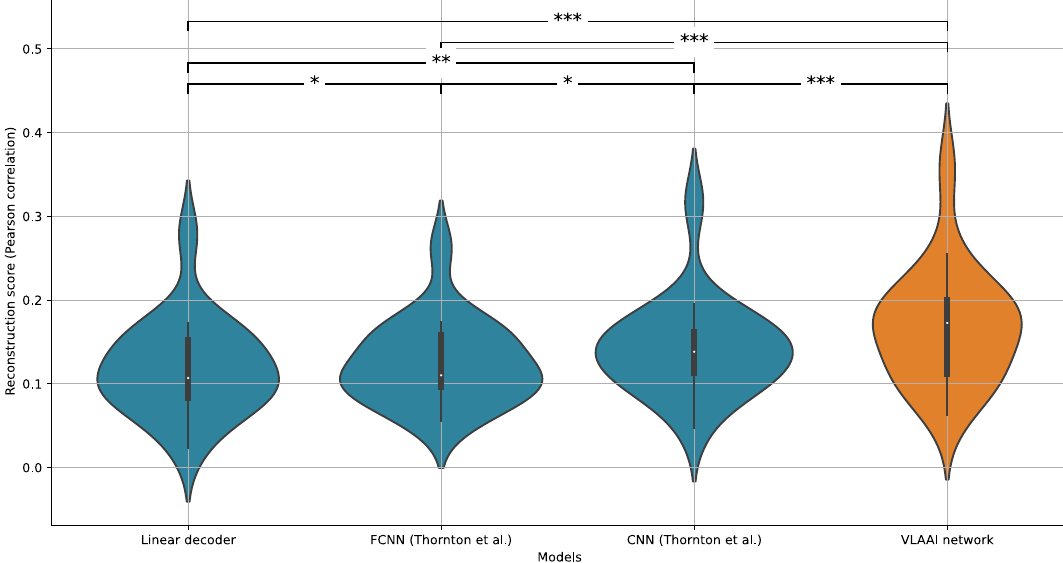
Figure 5. Evaluation of the baseline models and the VLAAI network on the single-speaker trials (50 seconds per trial) of the DTU dataset. While the reconstruction scores are lower for all models compared to the single- speaker stories dataset (see also Fig. 2), the general conclusions still hold. The VLAAI network significantly outperforms all other baseline models ( p <0.01), with a relative performance increase of 62% over the linear decoder. (n.s.: p ≤ 0.05, *: 0.01 ≤ p < 0.05, **: 0.001 ≤ p < 0.01, ***: p <